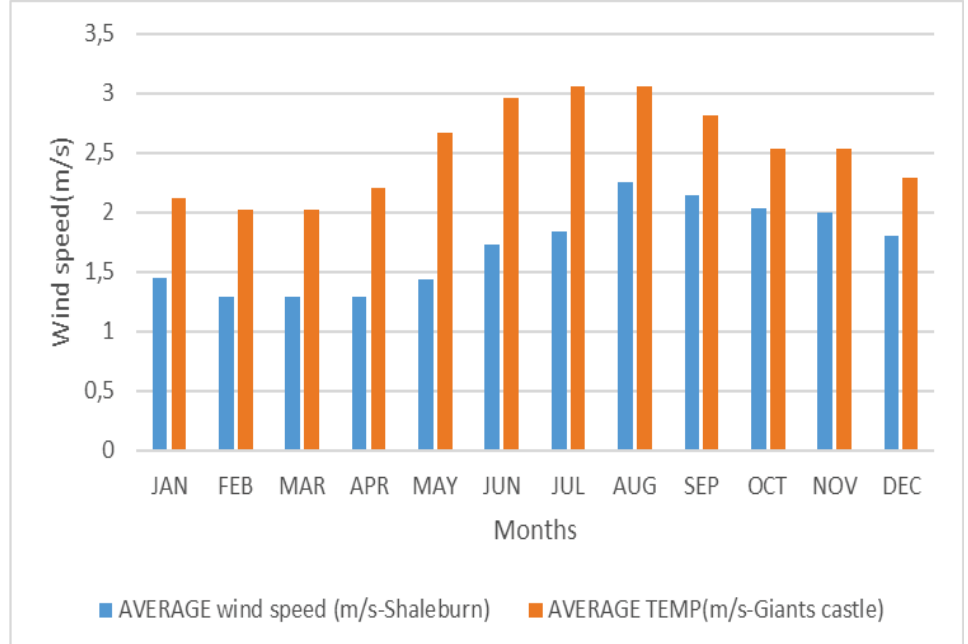
Fig. 12. Plot of average monthly wind speed at the two weather stations